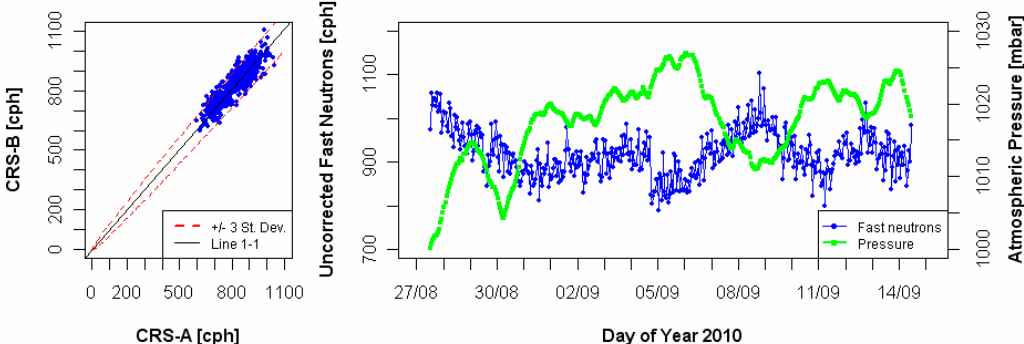
Figure 5. Ground albedo neutrons in moderated counter under cropped field conditions: (left) correlation of ground albedo neutron counting rates per hour between two CRS-1000 sensors, and (right) temporal variability of uncorrected ground albedo neutron counting rates per hour and local atmospheric pressure.